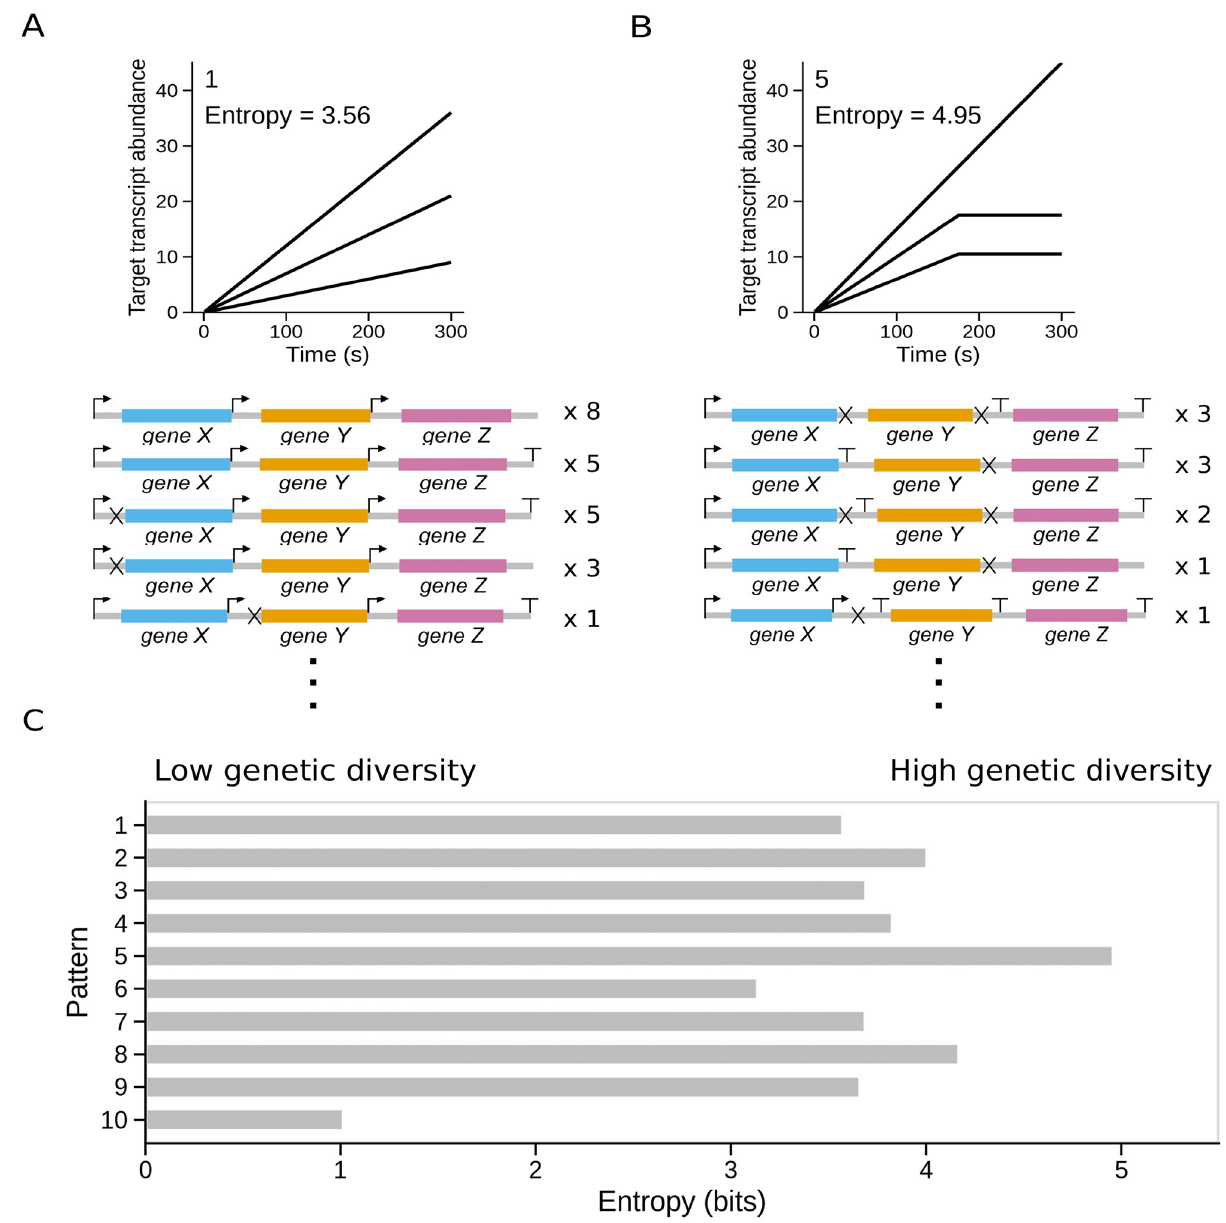
Fig 4. Diversity of successfully evolved genome architectures. A: A sample of the successfully evolved genome architectures for pattern #1 showing that multiple potential architectures can reproduce the target expression pattern. Only the architectures that evolved most frequently are shown. Multiples on the right indicate how often each architecture arose among 50 replicates. B: Similar to panel (A), a sample of the successfully evolved architectures for pattern #5. We note the much higher frequency of terminators and RNase cleavage sites in genome architectures evolved for pattern #5 versus pattern #1. C: Entropy values for the set of successfully evolved genome architectures for each target pattern. Lower values indicate that successful replicate simulations converged upon one or a small number of genome architectures. More specifically, an entropy value of 1 corresponds to their being effectively 2 (2 1 ) distinct architectures for a given pattern from amongst the replicates, while an entropy value of 5 corresponds to their being effectively 32 (2 5 ) distinct architectures.